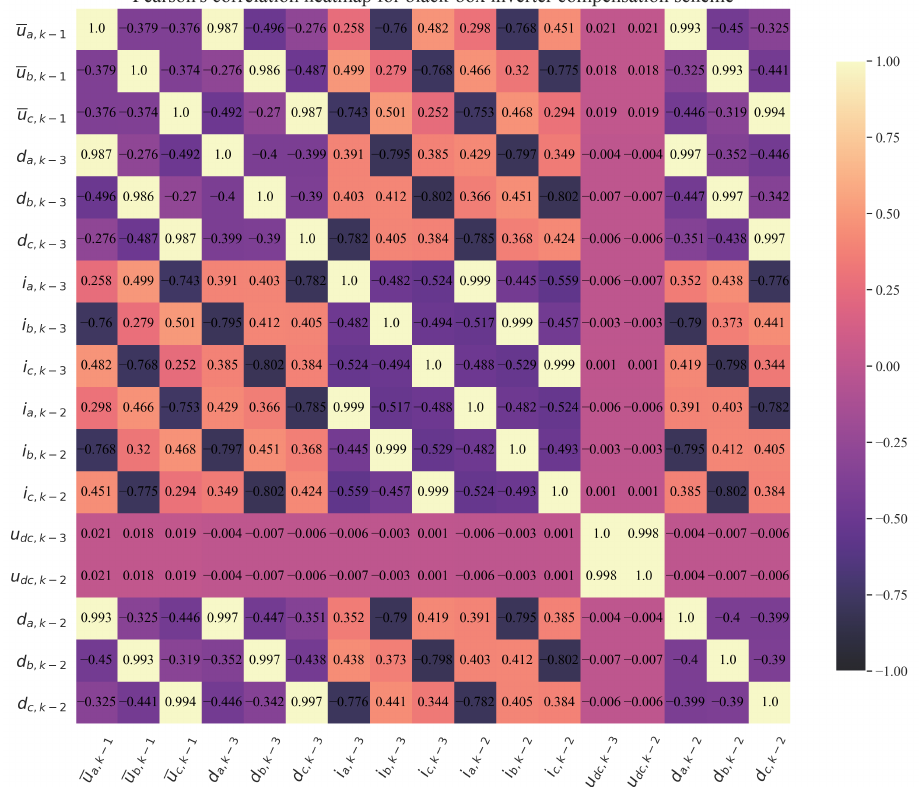
Figure 5. Pearson’s correlation heat-map for black-box inverter compensation